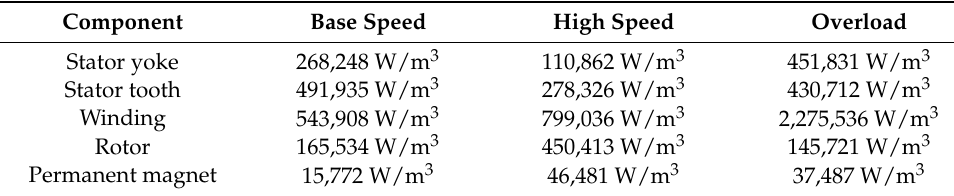
Table 9. Motor heat generation rate under main operating condition.